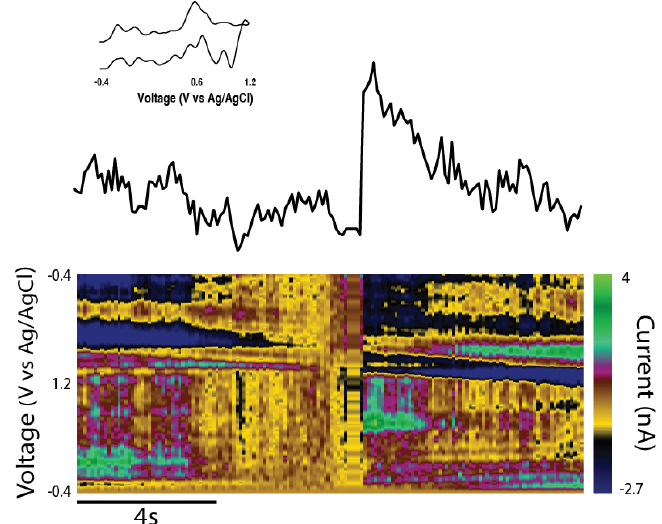
Figure 11. TE-NSPs elicited measurable striatal dopamine in rat 6-OHDA lesion model of PD. Evoked dopamine release was investigated in slices from implanted animals at 1-month in vivo. Color plot (bottom), cyclic voltammogram (inset), and time vs. concentration plot (top) of evoked dopamine release recorded in the striatum of an animal implanted with an enriched TE-NSP. The color plot exhibited an oxidation peak between 0.55 and 0.65 V and a reduction trough between − 0.2 and − 0.3 V, which are characteristic of dopamine. The maximum concentration of dopamine released by the implanted slice was approximately 95 nM following electrical stimulation. The data shown are an average of three collections, and the stimulation artifact was removed.